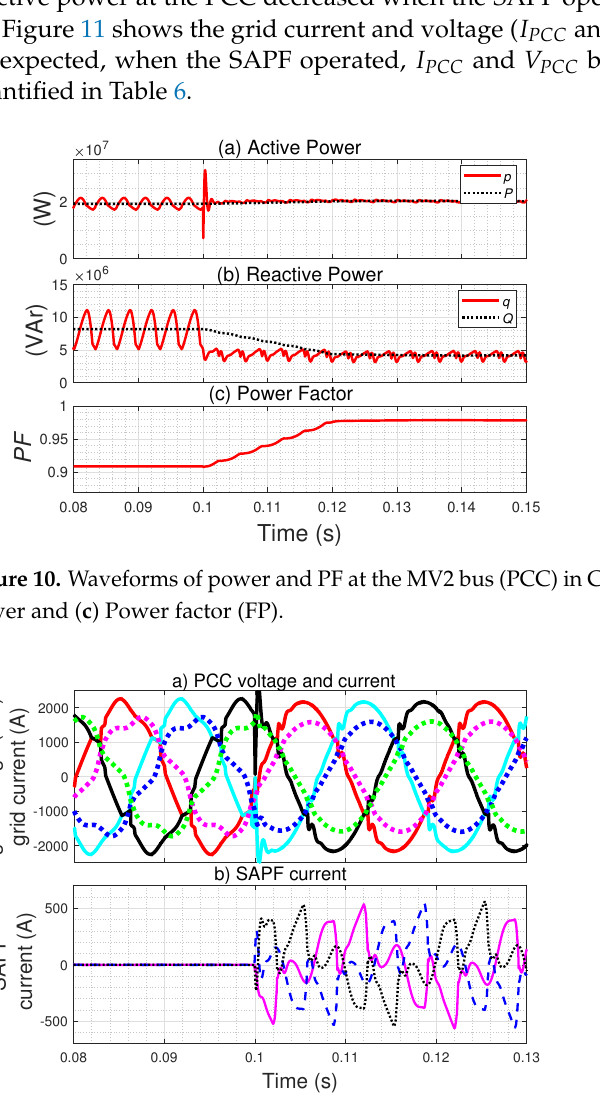
Figure 11. Circuit waveforms corresponding to Case 3: ( a ) Point of Common Coupling (PCC) voltage and current, and ( b ) SAPF